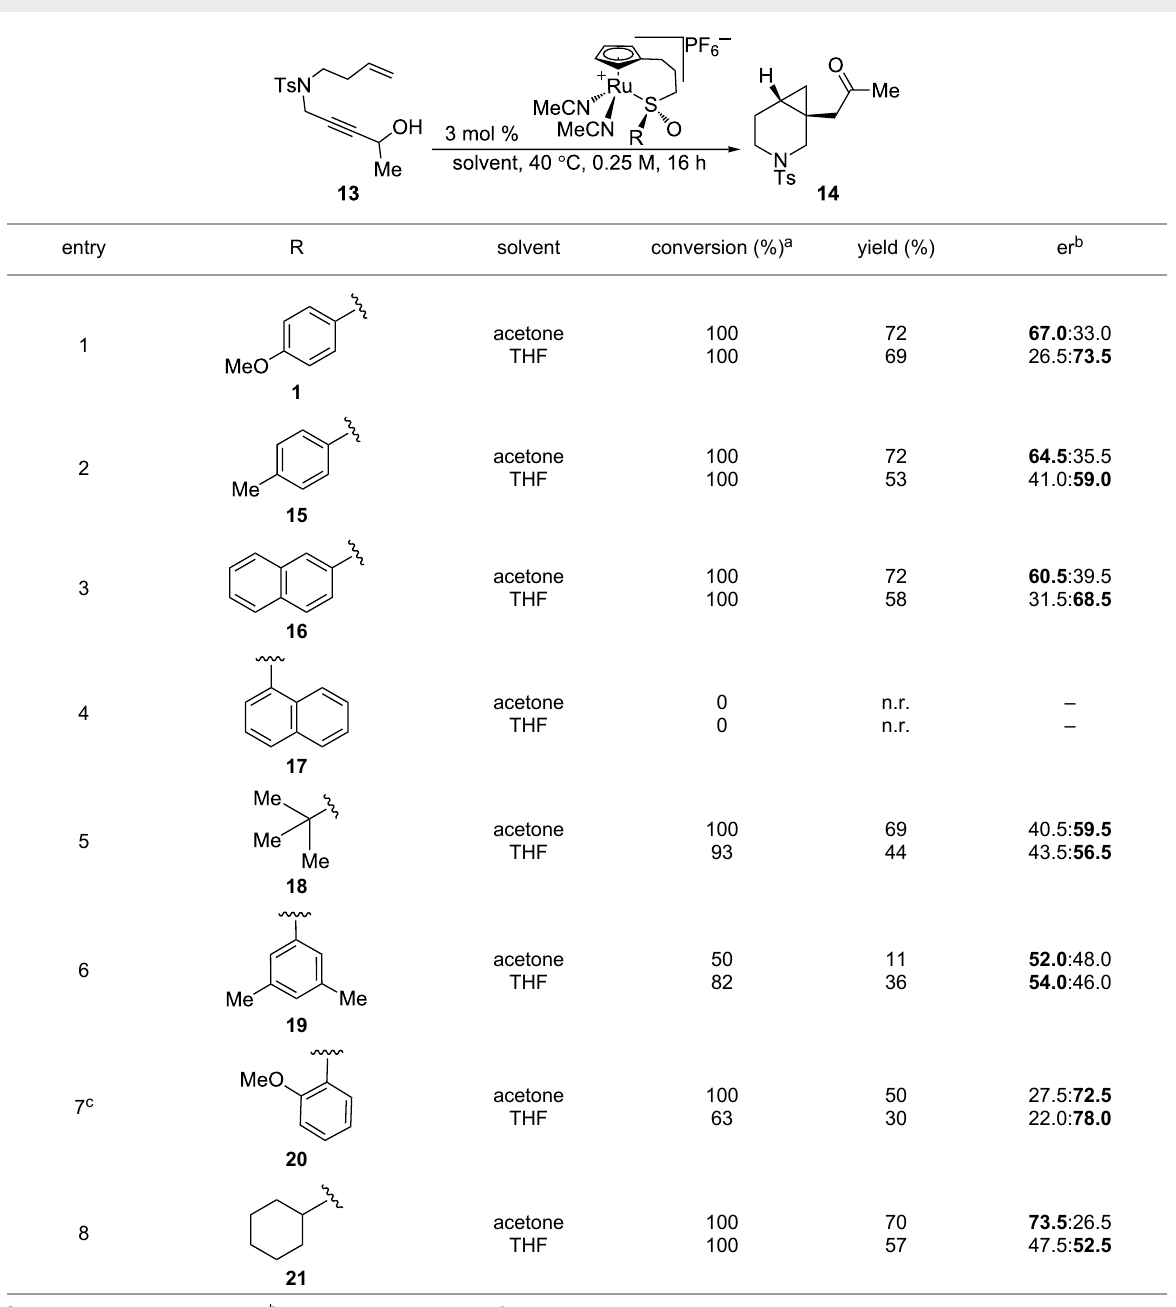
Table 3: Effect of the catalyst structure on the redox bicycloisomerization as described in